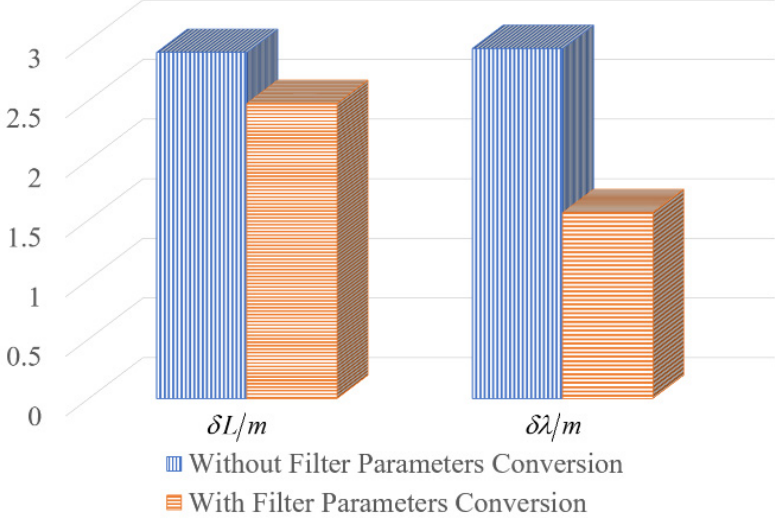
Figure 9. The horizontal position RMSEs of multi-information fusion autonomous navigation.